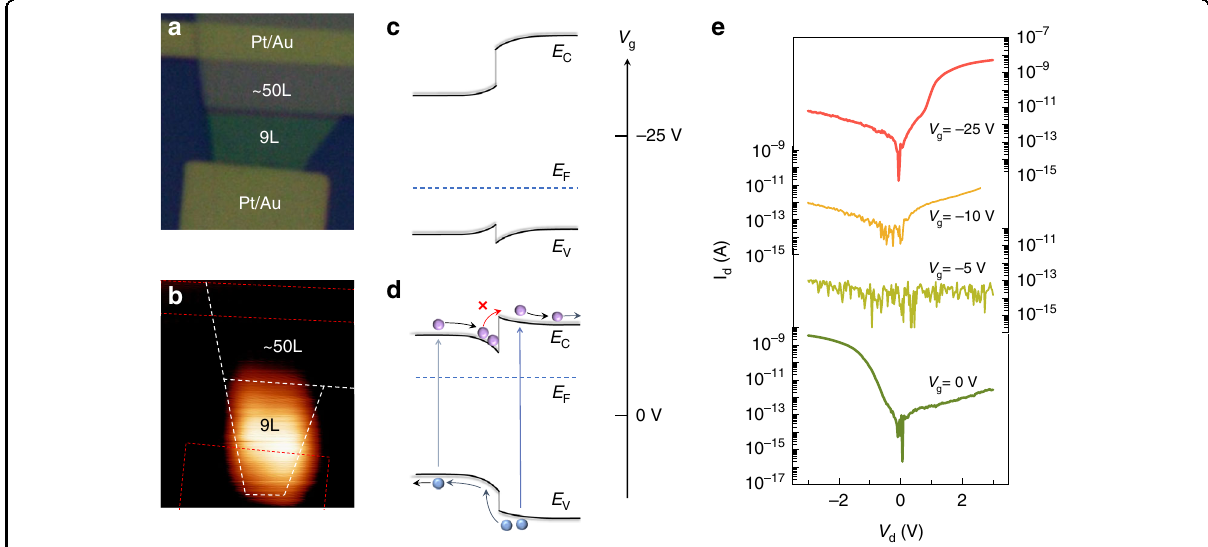
Fig. 4 Isotype layer junction. a Optical microscope image of the device, showing two stairs n-doped WSe 2 , 9L and ~50L, that are electrically connected by 15 nm Pt/50 nm Au. b SPCM image of the device. c , d Evolution of the energy-band structure with an increasing gate bias. e Dependence of output curve (I d -V d ) on the gate